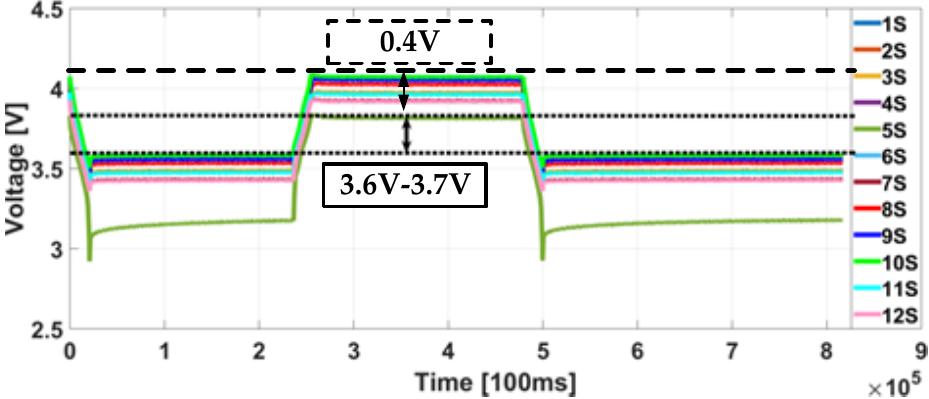
Figure 9. Discharging/charging voltages of 12 cells in the retired series/parallel battery pack, especially in the narrowed operating voltage range.